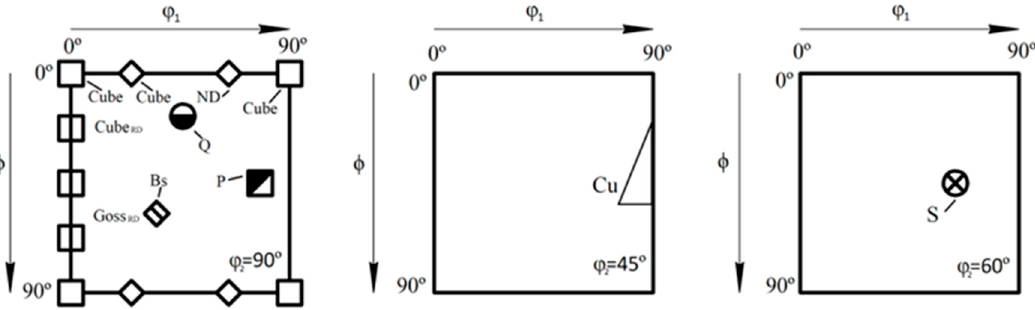
Figure 4. Ideal texture orientations on ODF .